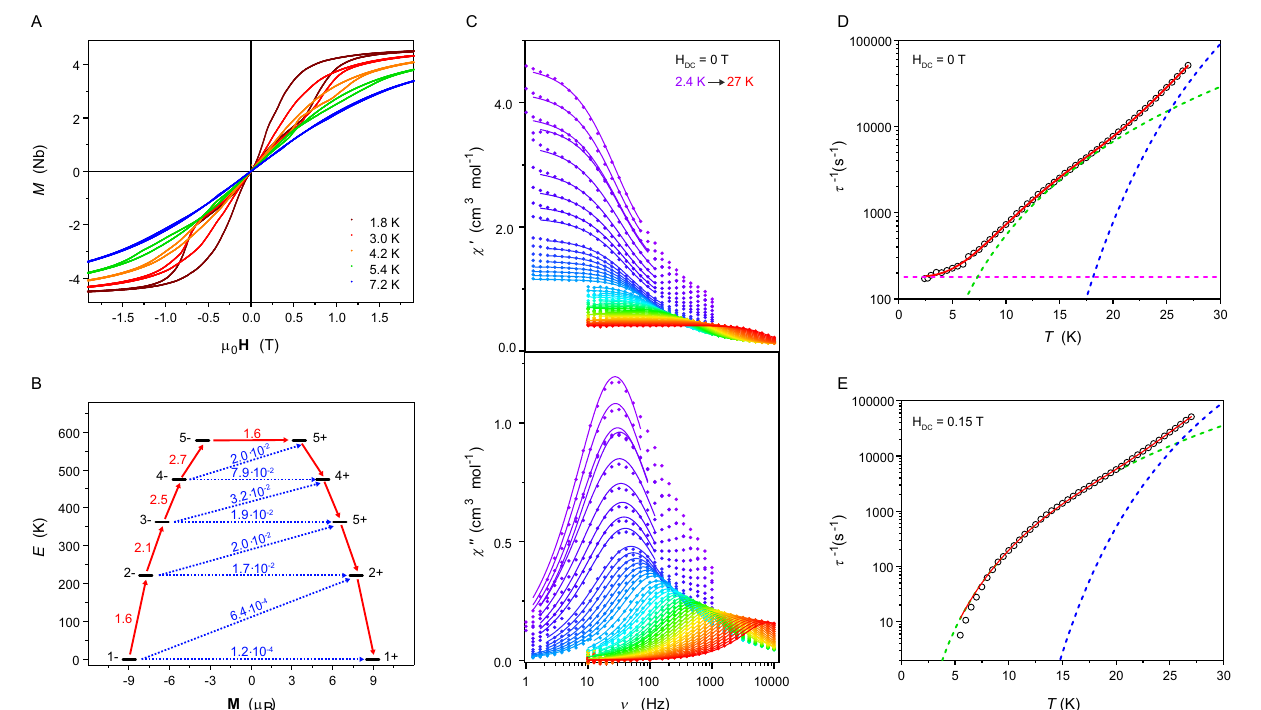
Fig. 2 Magnetic properties of ErRe 3 . Magnetization ( M ) hysteresis loops were recorded with the 2.2 mT s − 1 magnetic fi eld ( μ 0 H ) sweep rate in the − 2 to 2 T range ( A ). The energy of the calculated Kramers Doublets (KDs) arising from the splitting of the 4 I 15/2 multiplet of Er III in ErRe 3 with the most probable relaxation pathway represented by red arrows ( B ). In-phase ( χ ‘ ) and out-of-phase ( χ “ ) AC molar magnetic susceptibility recorded at zero magnetic fi eld in the 2.4 – 27 K temperature range, demonstrating the slow magnetization dynamics of ErRe 3 , solid lines are the best fi ts to the generalized Debye model with parameters presented in Supplementary Table 2 ( C ). Temperature dependence of the magnetization relaxation rate τ − 1 ( T ) at zero ( D ) and 0.15 mT ( E ) magnetic fi eld obtained from the generalized Debye fi tting of the respective AC molar magnetic susceptibility measurements (circles — experimental points, red line — best fi ts using Eq. 1 ( D ) and Eq. 2 ( E ), blue dashed line — Orbach relaxation, green dashed line — Raman relaxation, magenta dashed line — QTM relaxation). Standard deviations in A , C , D , and E are smaller than the size of the data